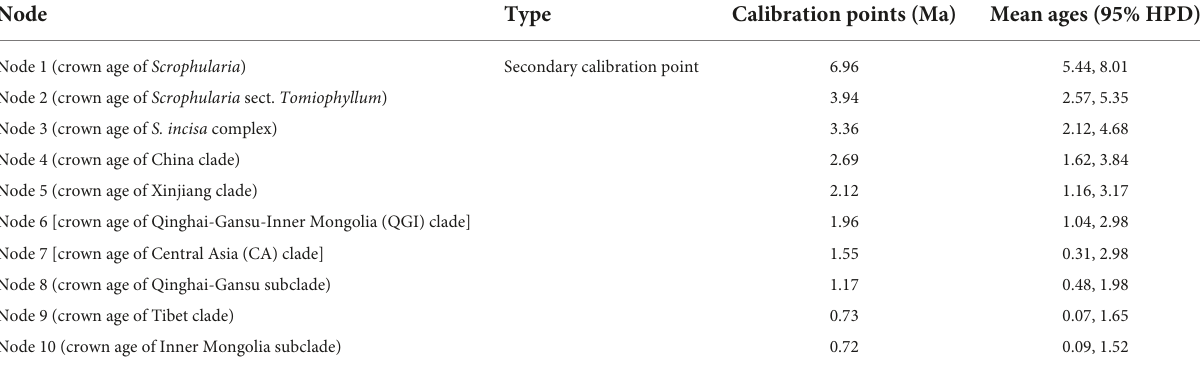
TABLE 2 Summary of cpDNA-based divergence time estimation results under a Bayesian approach. Node Type Calibration points (Ma) Mean ages (95%